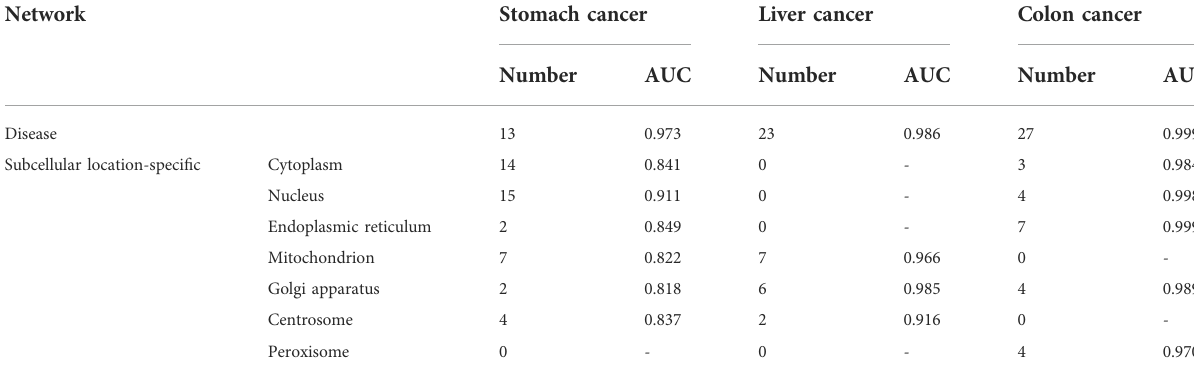
TABLE 6 Class fi ciation performance of unique leader genes from disease networks and from subcellular location-speci fi c networks. Network Stomach cancer Liver cancer Colon cancer Number AUC Number AUC AUC